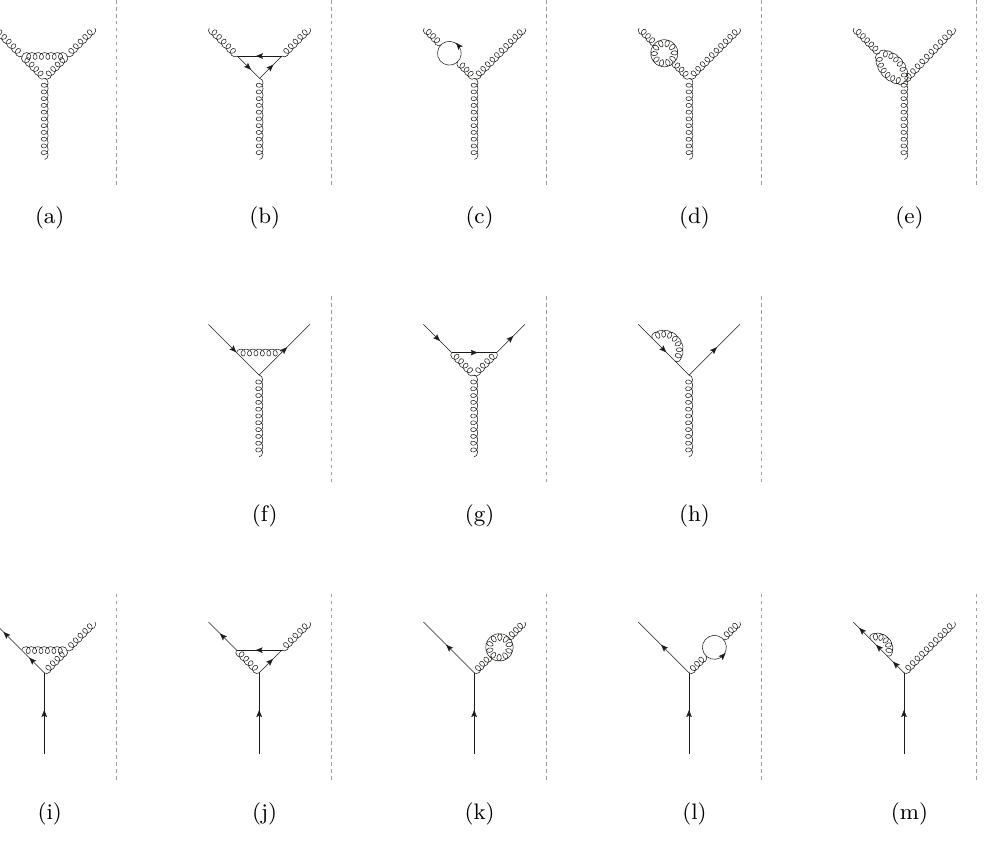
or a . Analogous rules 1 2